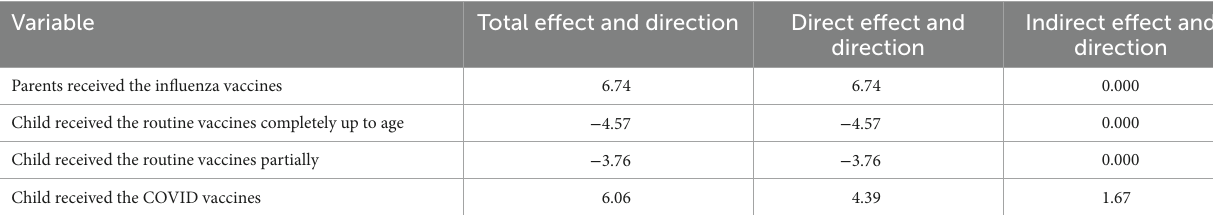
TABLE 3 Value and direction of the total, direct, and indirect effect of endogenous (intermediate) variables on parental attitude toward childhood influenza